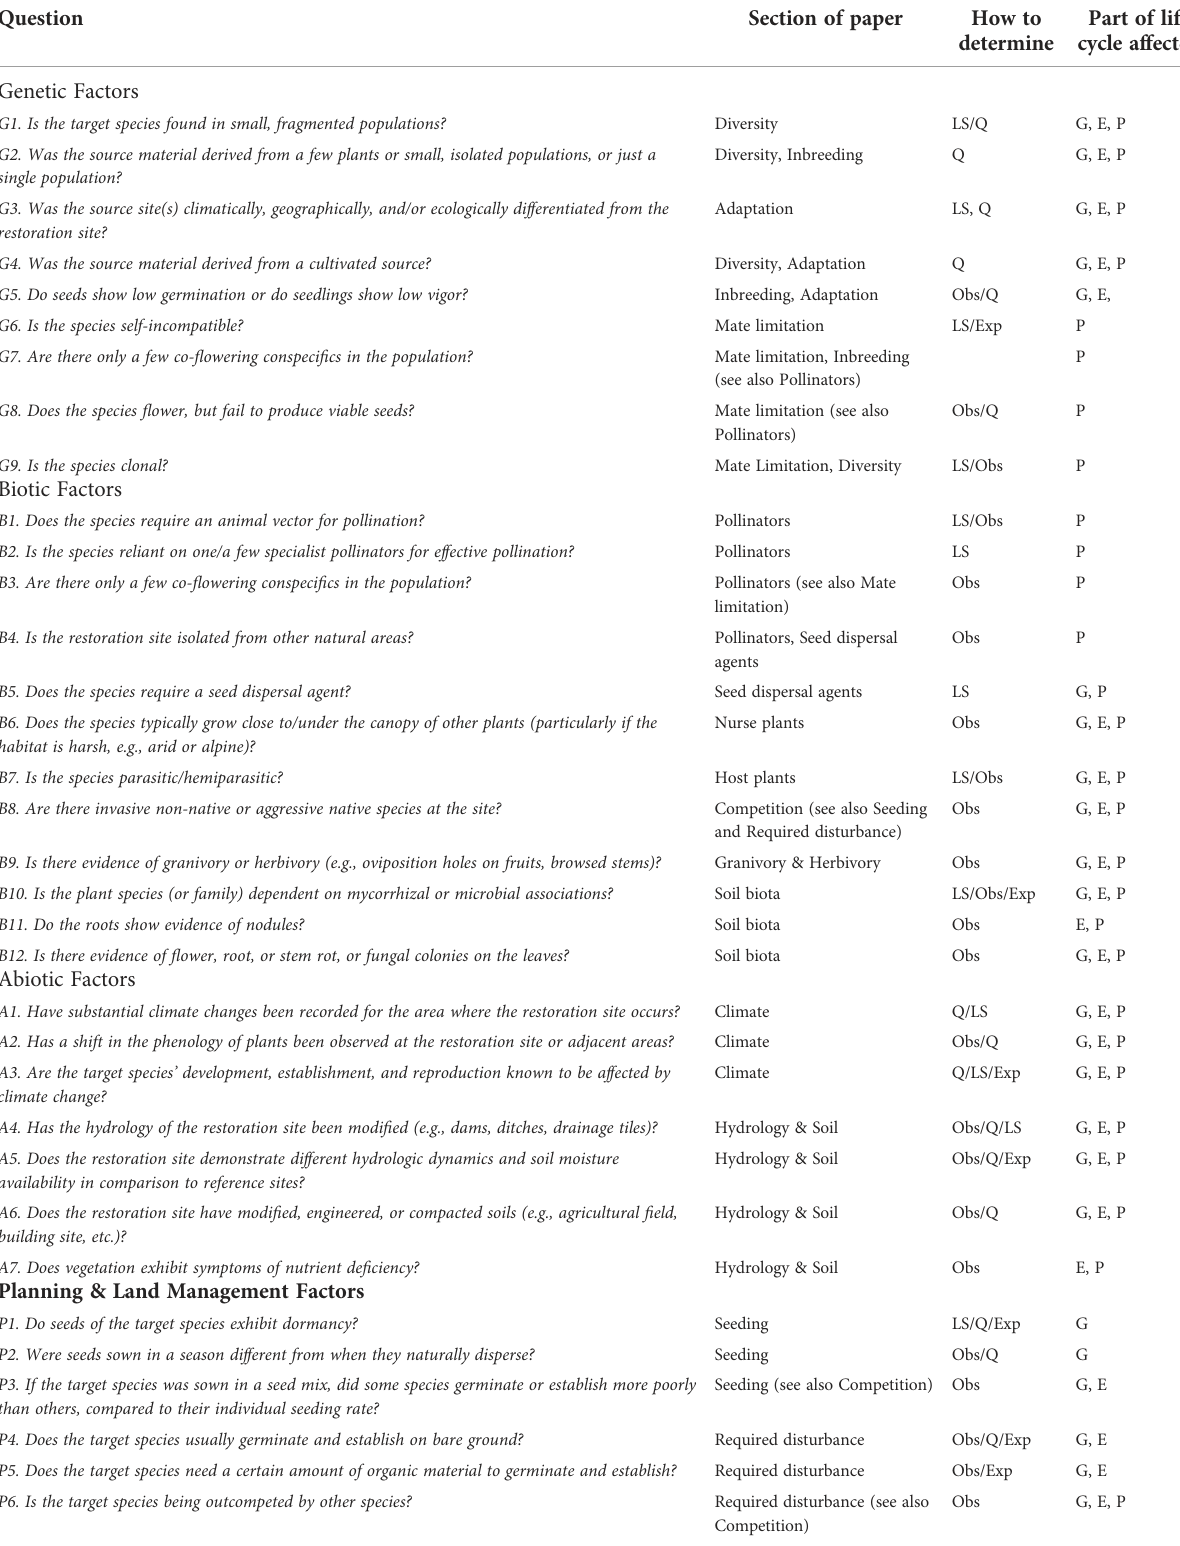
TABLE 1 List of questions to identify possible reasons a target species fails to persist as a viable population at a site. For each question, a “ yes ” answer means the factor may be affecting the presence of the target